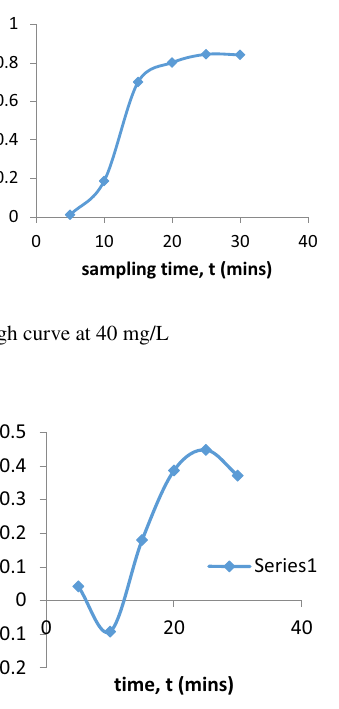
Fig. 6 Breakthrough curve at bed height 6 cm (0.6 g)